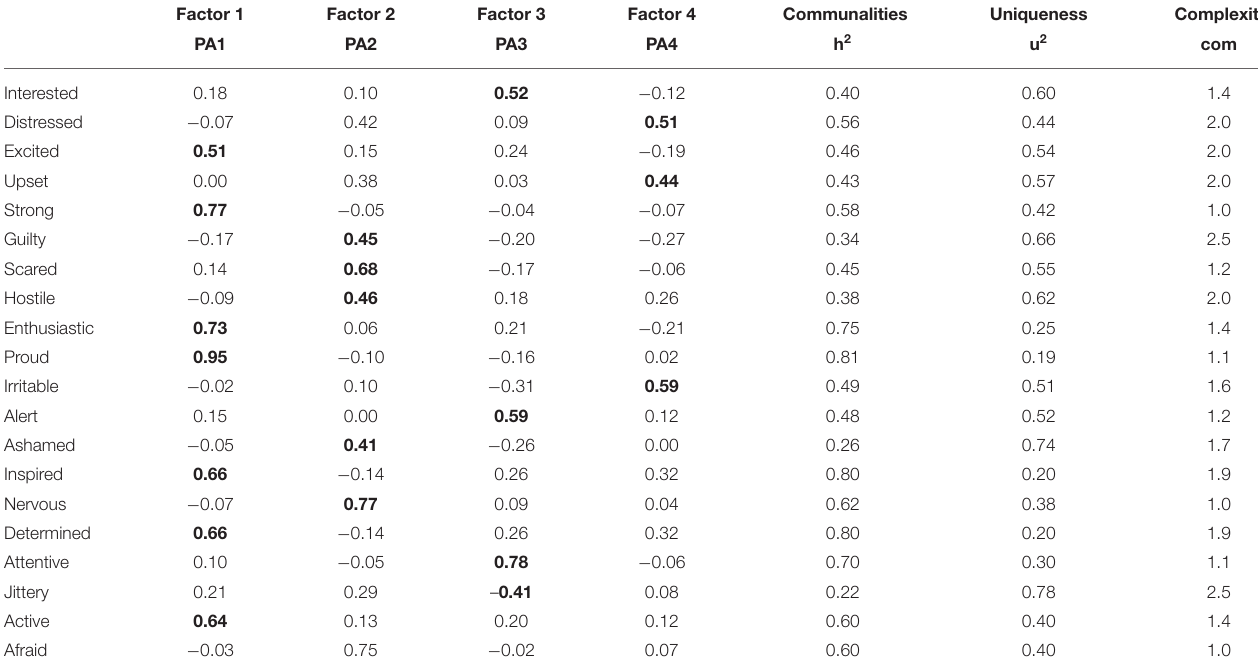
Bold values represent variables with high loading